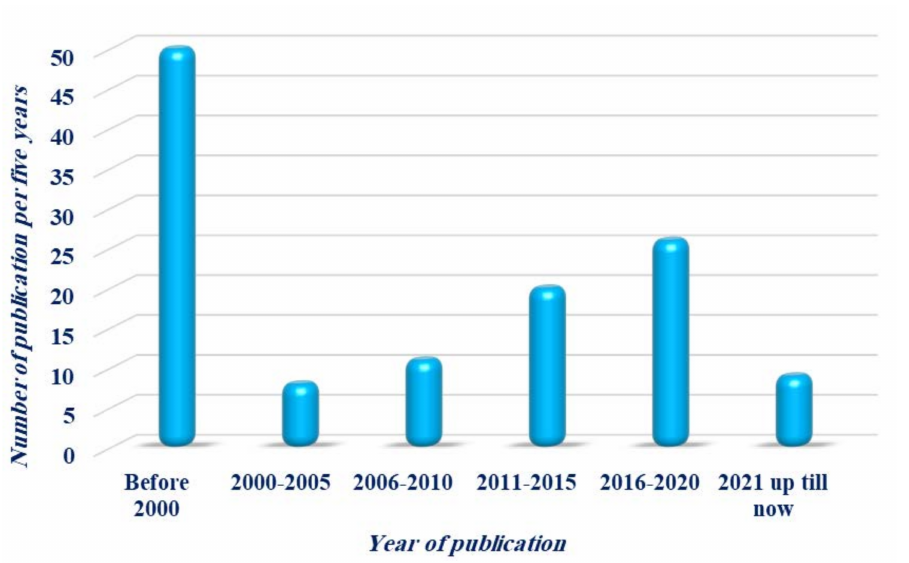
Figure 11. The rate of publication on the genus Dictyota .